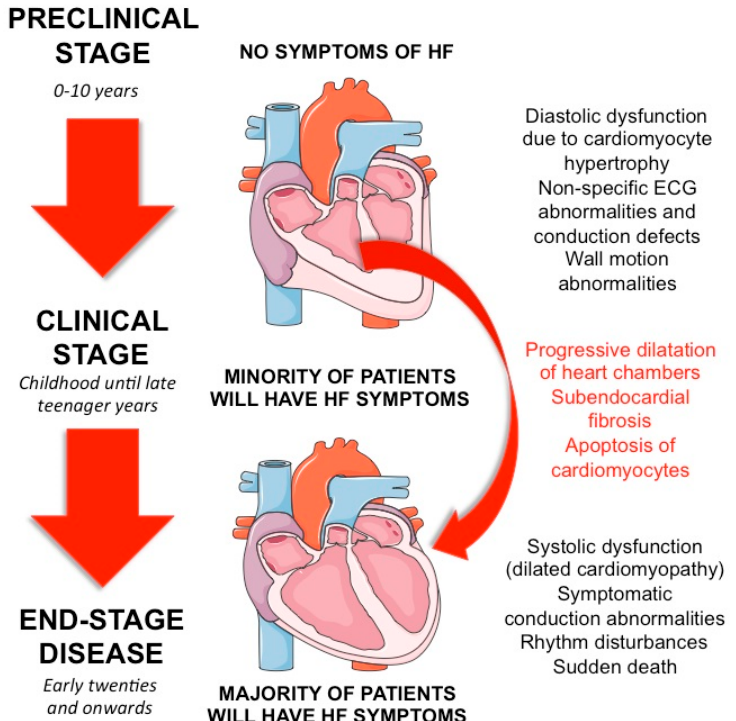
Figure 1. Natural course of cardiovascular impairment in patients with Duchenne’s muscular dystrophy divided in three cardinal phases: preclinical phase of disease when patients have no symptoms of